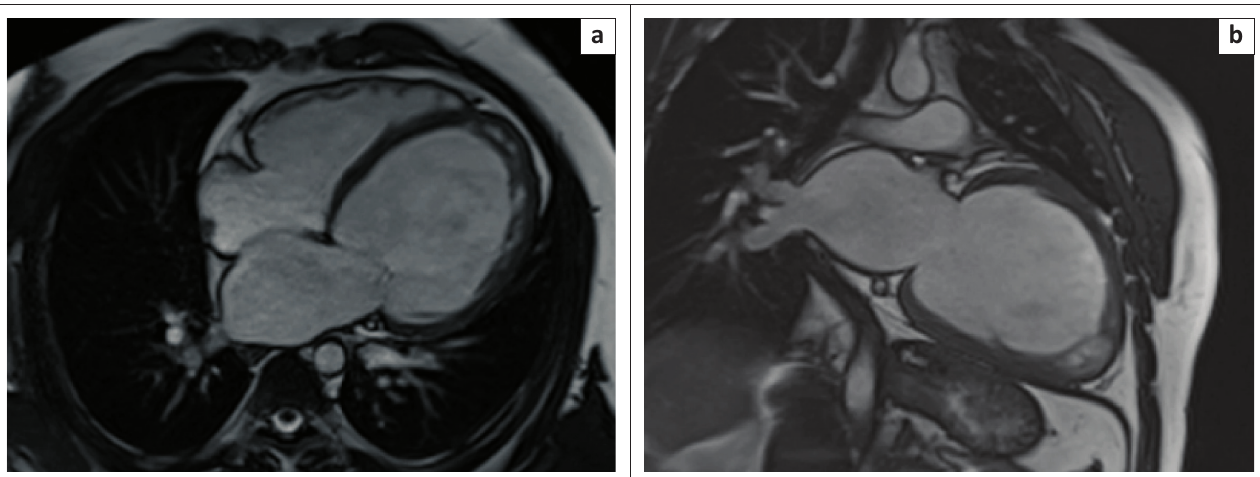
FIGURE 4: Four-chamber (a) and 2-chamber (b) SSFP images showing a markedly dilated left ventricle in a patient with known HIV-associated cardiomyopathy.